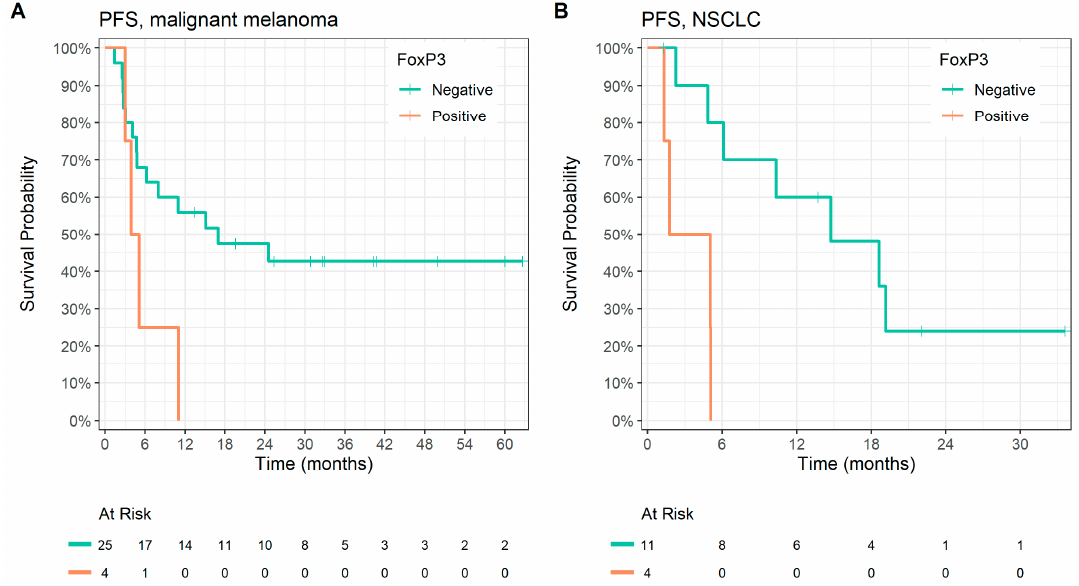
Figure 2. Kaplan–Meier analysis of progression-free survival according to FoxP3 expression in ( A ) malignant melanoma, median PFS was 17.0 vs. 4.5 months, p = 0.048; ( B ) NSCLC, median PFS was 14.8 vs. 1.8 months, p = 0.003. Table 3. Association of assessed IHC markers with survival parameters in the melanoma